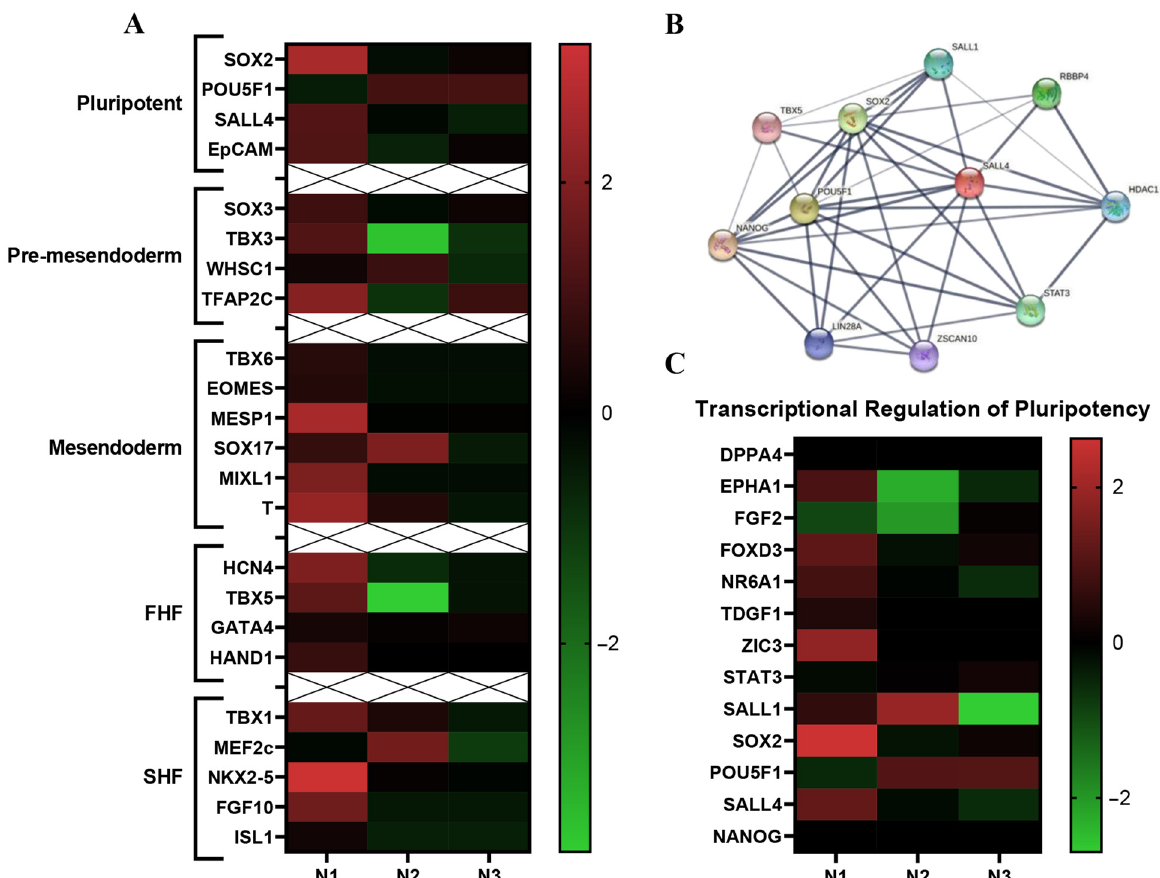
Figure 4. Stage specific differences within the Isl-1+ neonatal CPC population. Heatmap of markers that identify stages (pluripotent, pre-mesendoderm, mesendoderm, FHF, SHF) of CPC development between the individual neonatal Isl-1+ CPC clones. Neonate 1 expresses the highest number of early- stage transcripts ( A ). String ID of genes that play a role in the transcriptional regulation of pluripotency pathway ( B ). Neonate 1 expresses the highest number of genes associated with the transcriptional regulation of pluripotency pathway ( C ).